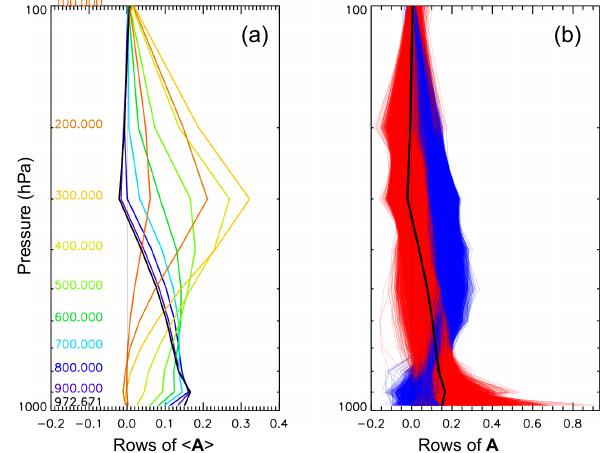
Fig. 2. MOPITT CO AKs for 2006 CONUS observations. Figure 2. MOPITT CO AKs for 2006 CONUS observations. (a) CONUS average AK, with colors (a) CONUS average AK, with colors corresponding to pressure lev- corresponding to pressure levels indicated on the left. (b) Individual AK rows for 31904 CONUS observations els indicated on the left. (b) Individual AK rows for 31904 CONUS for the surface (red lines) and 500 hPa (blue lines) and average surface AK (black line). observations for the surface (red lines) and 500hPa (blue lines) and average surface AK (black